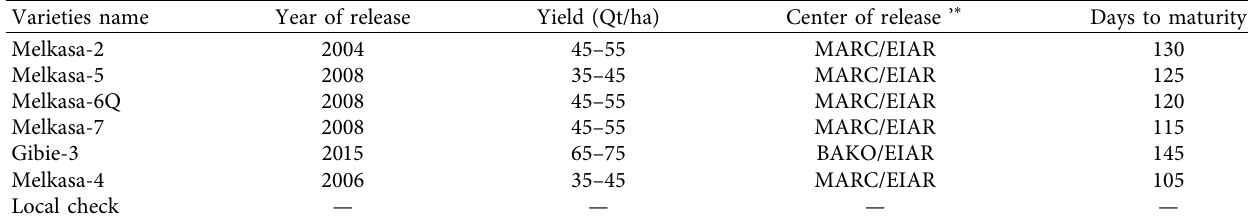
Table 2: List and passport data of improved open-pollinated maize varieties.